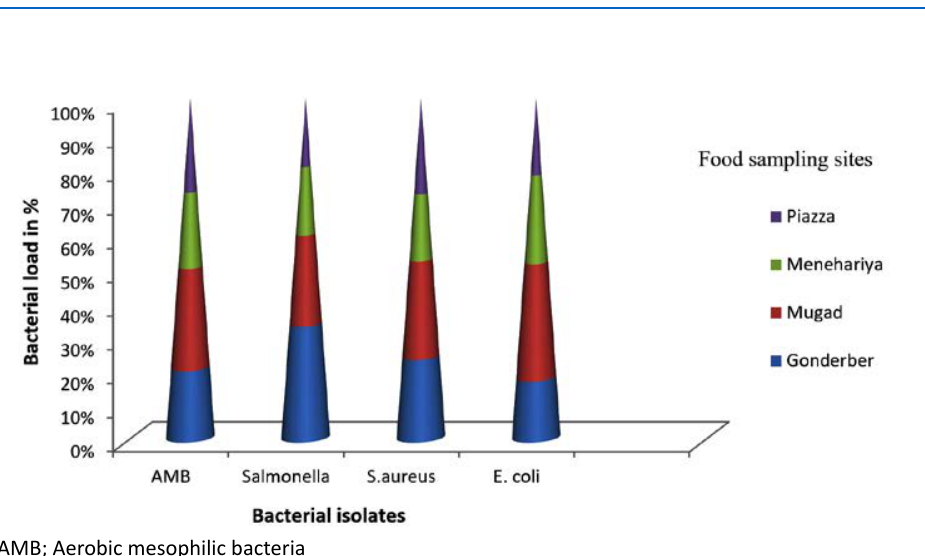
Fig. 2. Aerobic mesophilic bacteria and isolated species in street vended food Table 2. Food safety awareness and handling practices of respondents Parameter